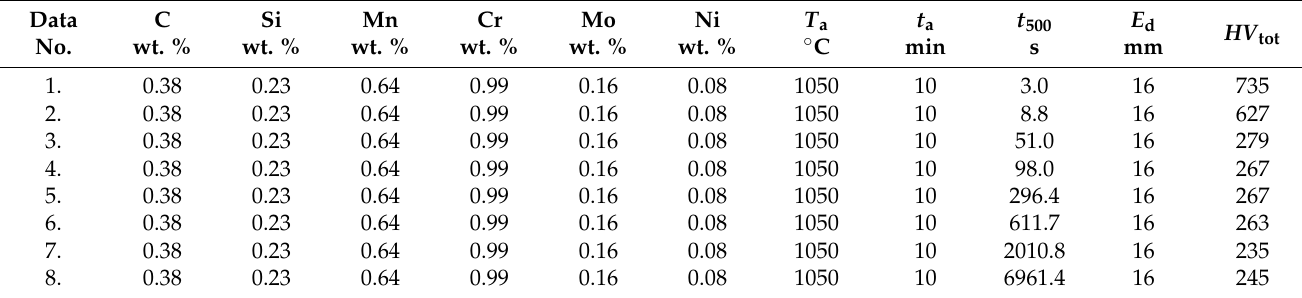
Table 3. Sample dataset for steel